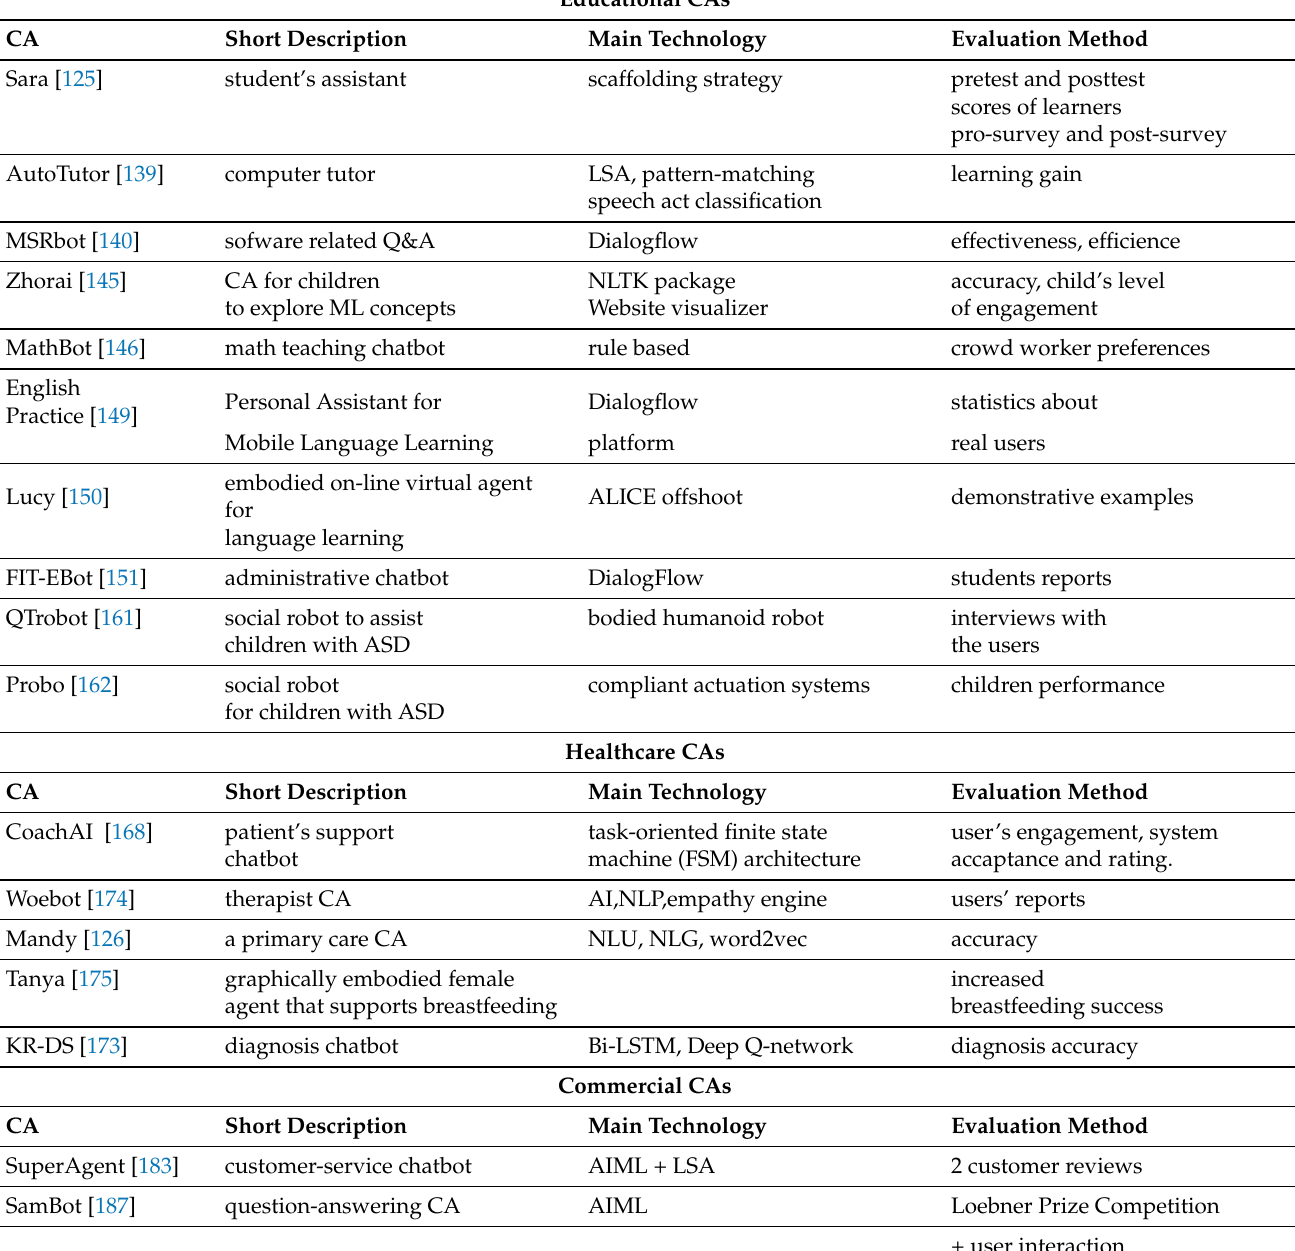
Table 2. Technologies and evaluation methods for main CA applications: Part